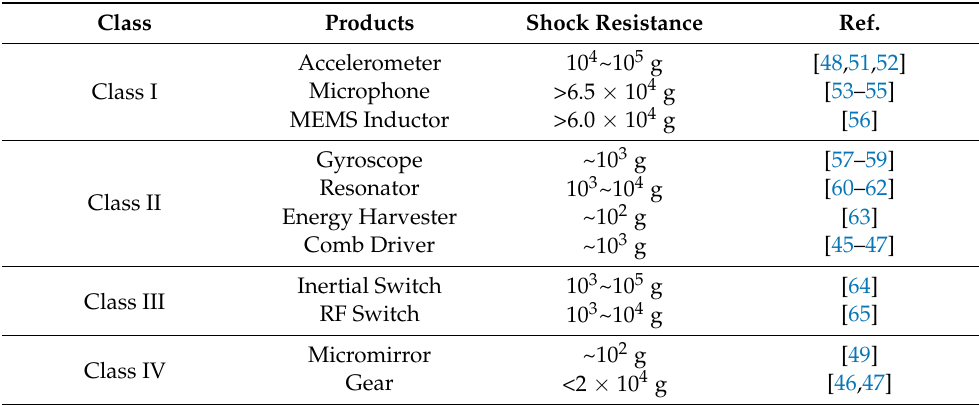
Table 4. Shock Experimental Research of